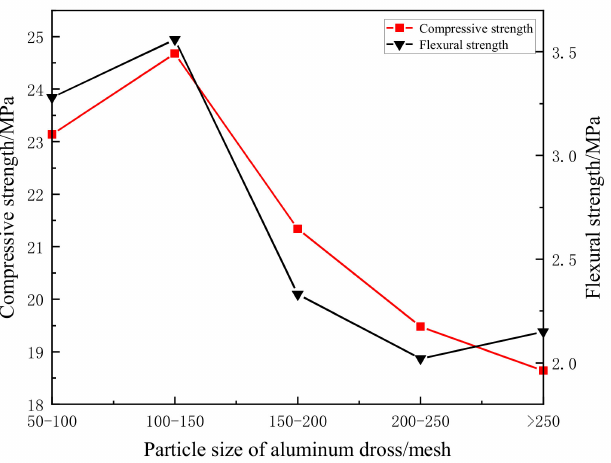
Figure 11. Compressive and flexural properties of aluminum dross non-fired bricks under different aluminum dross particle